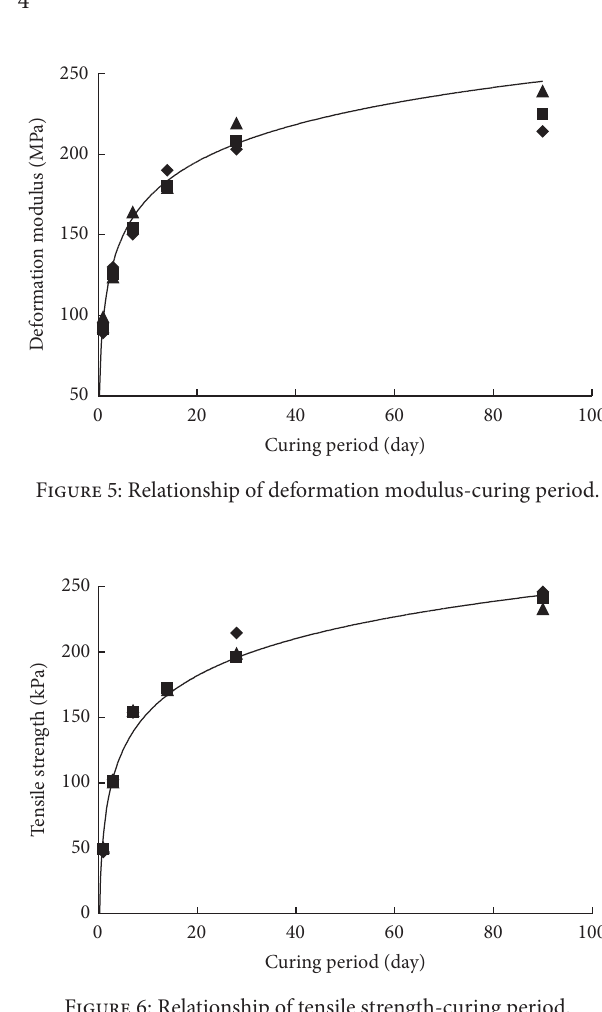
Figure 6: Relationship of tensile strength-curing period.